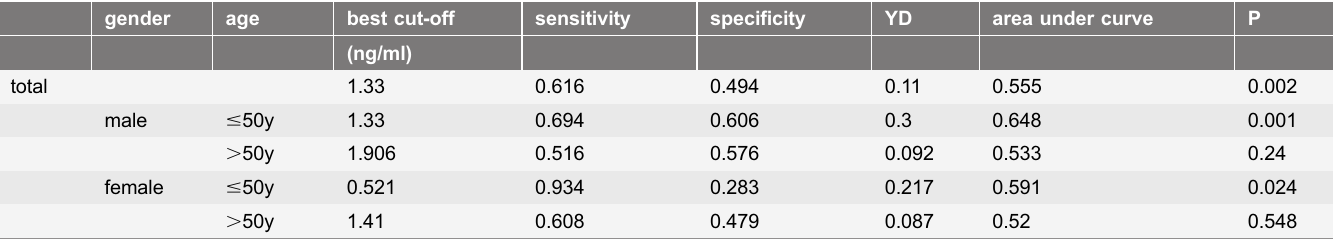
Table 6. Efficiency of serum OPN in discriminating atrophic gastritis.